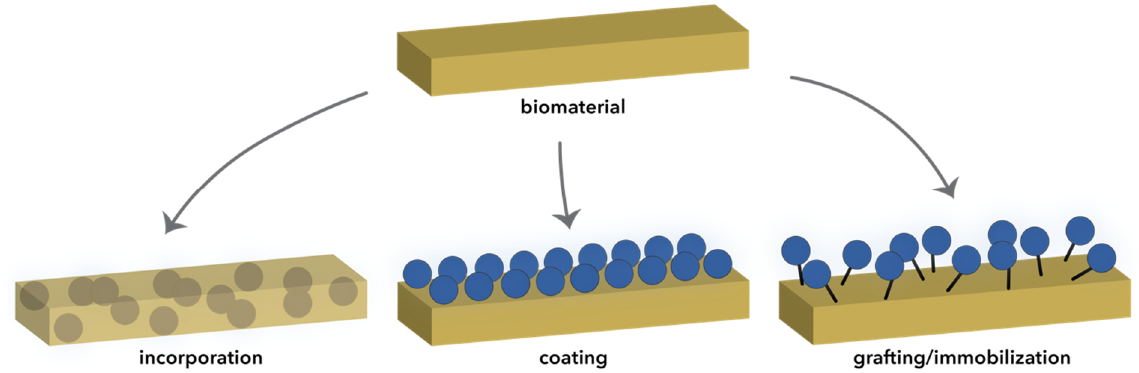
Figure 6. Schematic representation of the main strategies for obtaining composite materials based on inorganic NPs and organic/inorganic films.